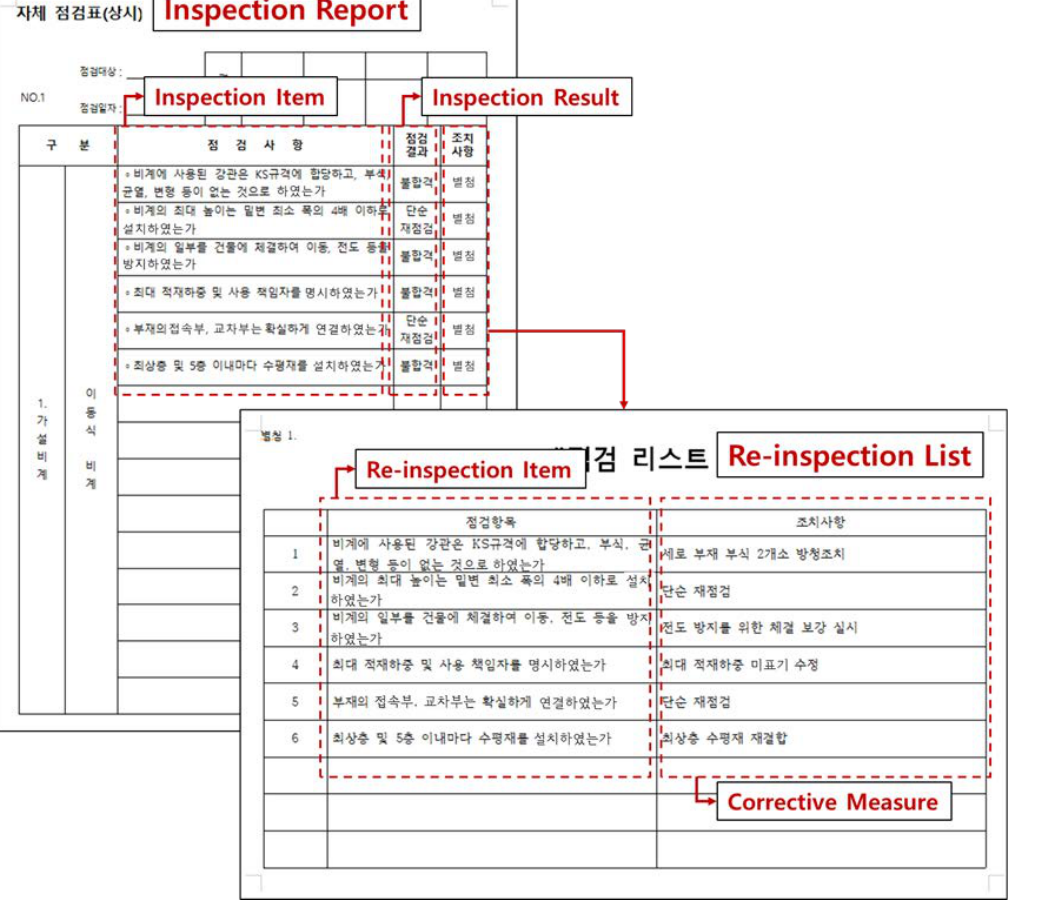
Figure 16. Quality inspection module—quality inspection report creation.